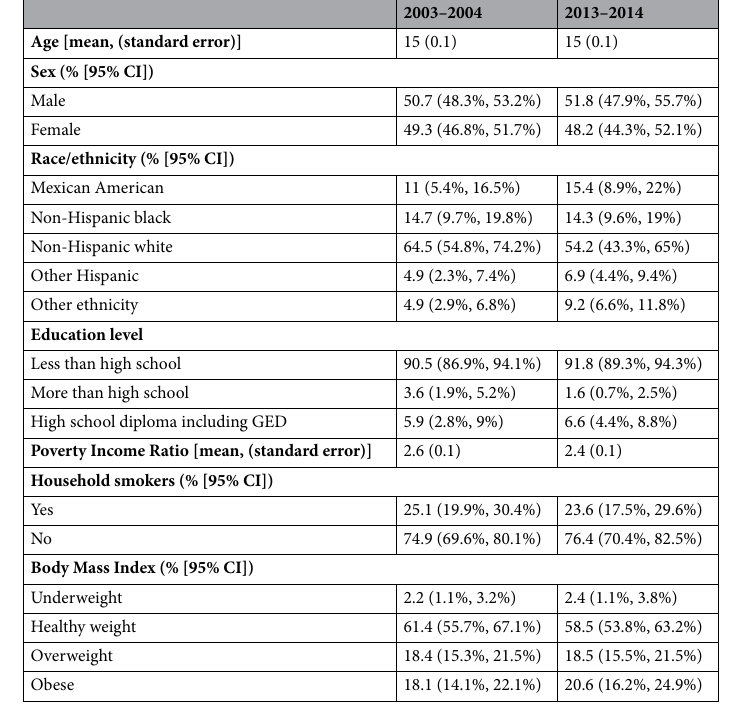
Table 1. Estimated (weighted) background characteristics and categories of Body Mass Index of the study population from the 2003–2004 and 2013–2014 NHANES survey